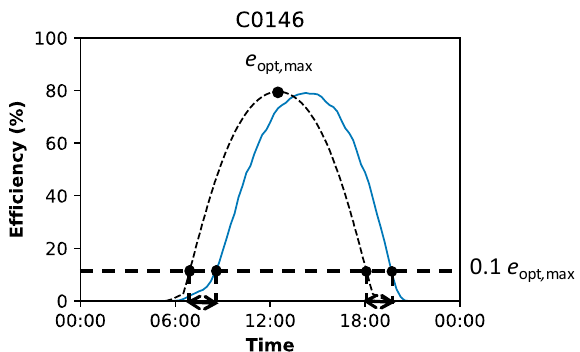
Figure 2. Estimation of orientation index from a weekly mean efficiency curve. The blue curve indicates the observed weekly mean efficiency, and the black dashed curve indicates the simulated efficiency under optimum conditions. Black solid circles denote the optimum efficiency maximum, e opt,max , and points where observed and optimum efficiency increase or decrease to 10% of the optimum efficiency maximum.